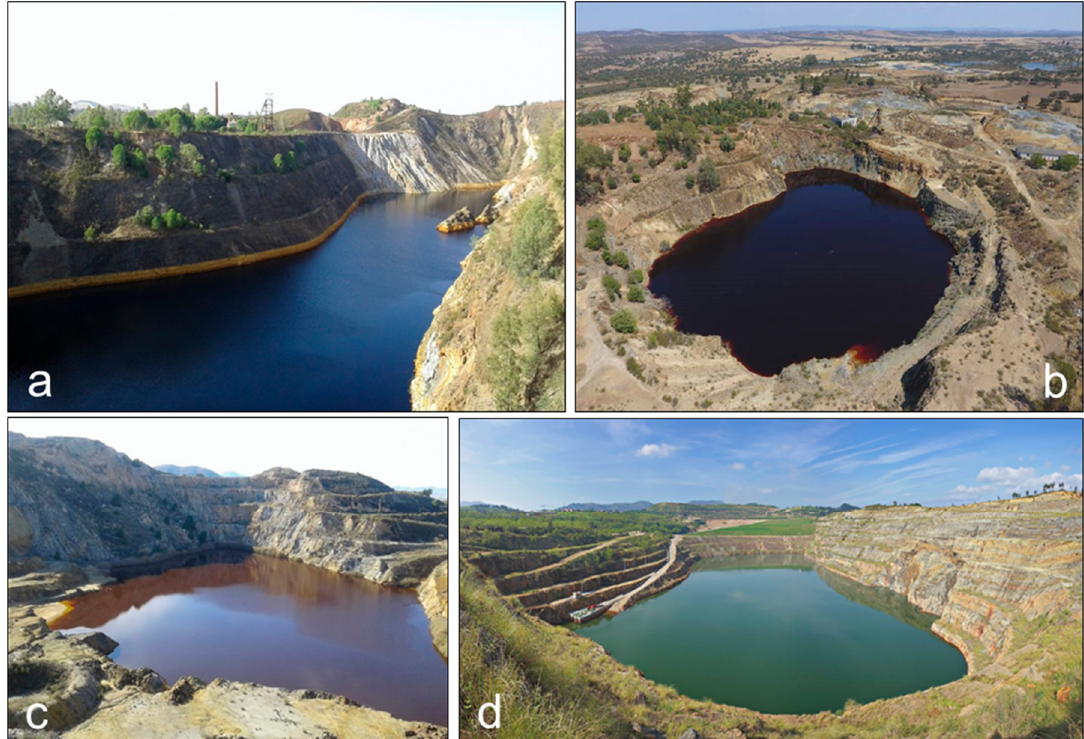
Figure 1. Panoramic views of four different pit lakes in Spanish mine districts, which have been selected for this study: ( a ) La Zarza; ( b ) Guadiana; ( c ) Brunita; and ( d ) Reocín. The water chemistry of these four pit lakes (major cations, sulfate, and trace metals) is given in Table 1.